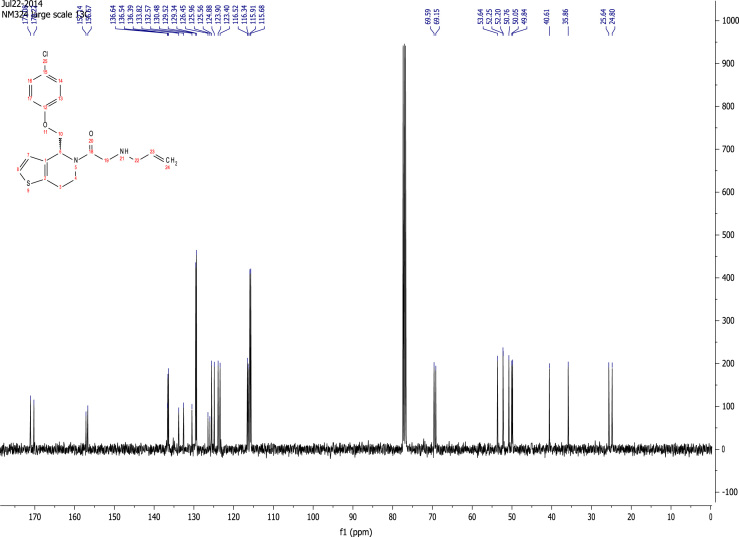
13C NMR (101 MHz, CDCl3) of RU-SKI 41
(9a).